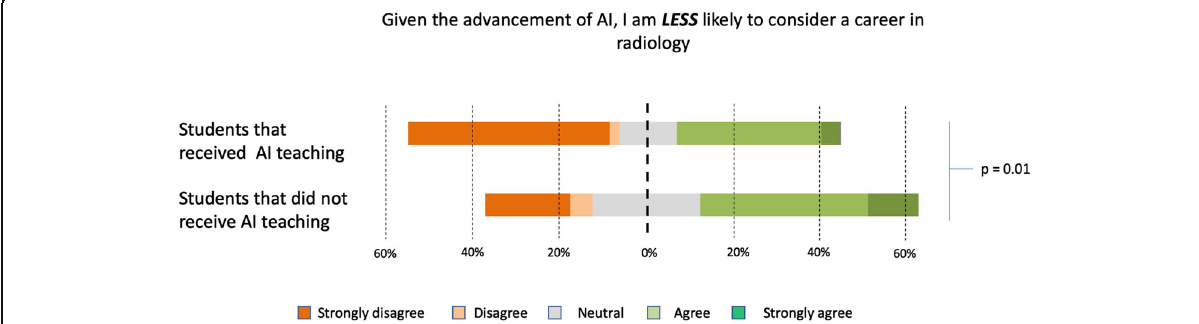
Fig. 4 Comparison of the likelihood of considering radiology as a career between students who receive AI teaching against those that did not